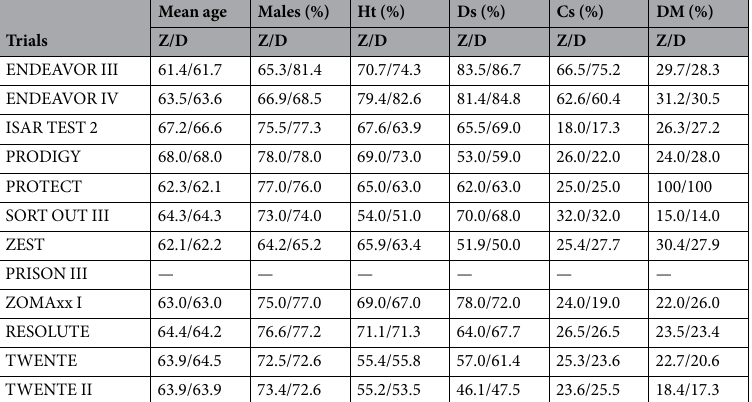
Table 4. Baseline features of the patients. Abbreviations: Z: zotarolimus eluting stents, D: sirolimus/paclitaxel or everolimus eluting stents, Ht: hypertension, Ds: dyslipidemia, Cs: current smoker, DM: diabetes mellitus.